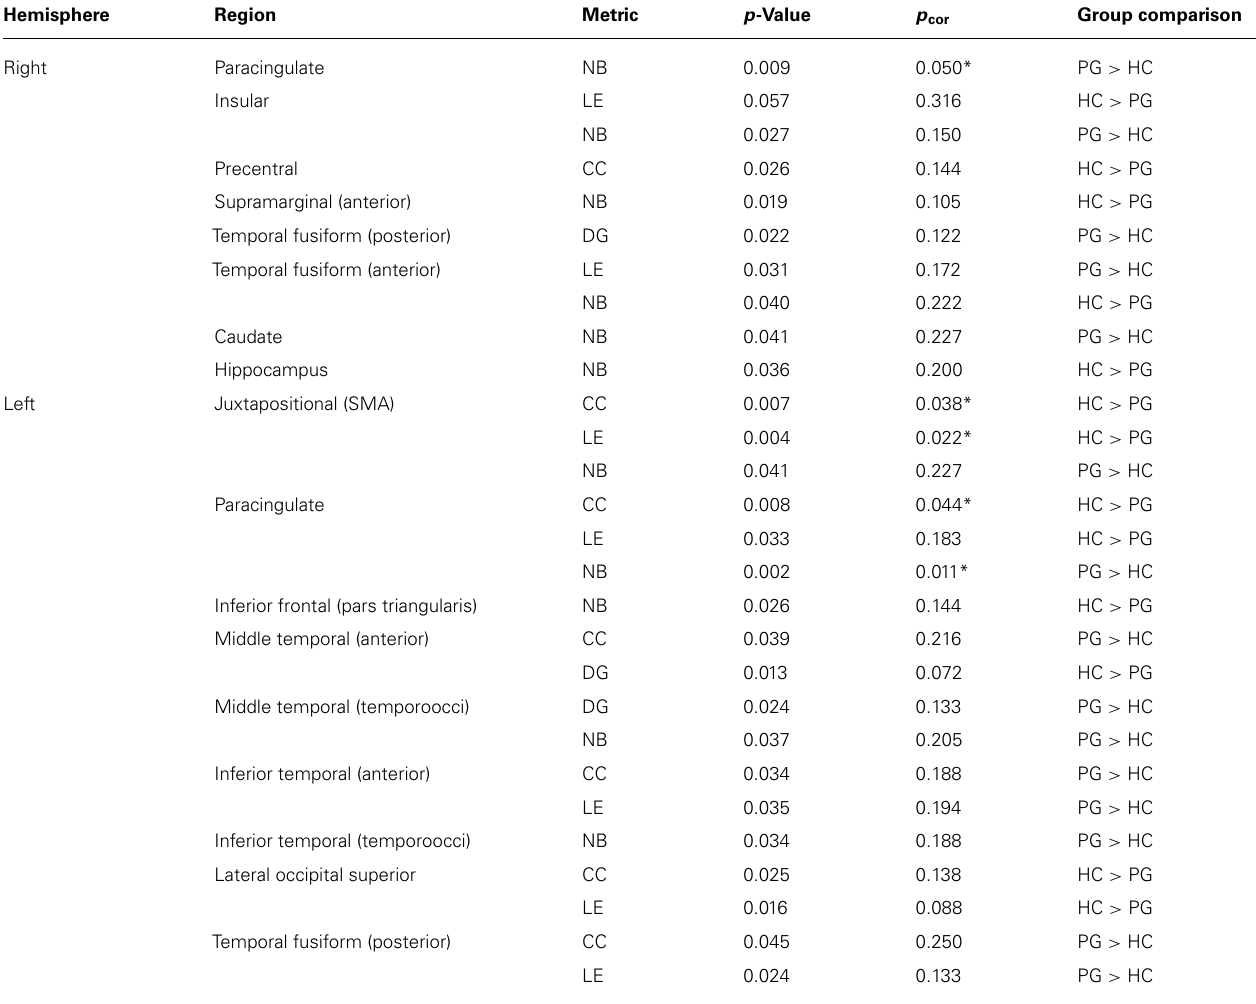
Table 2 | Significant differences in all metrics using area under the curve (AUC) for pathological gamblers (PG) and healthy controls (HCs).